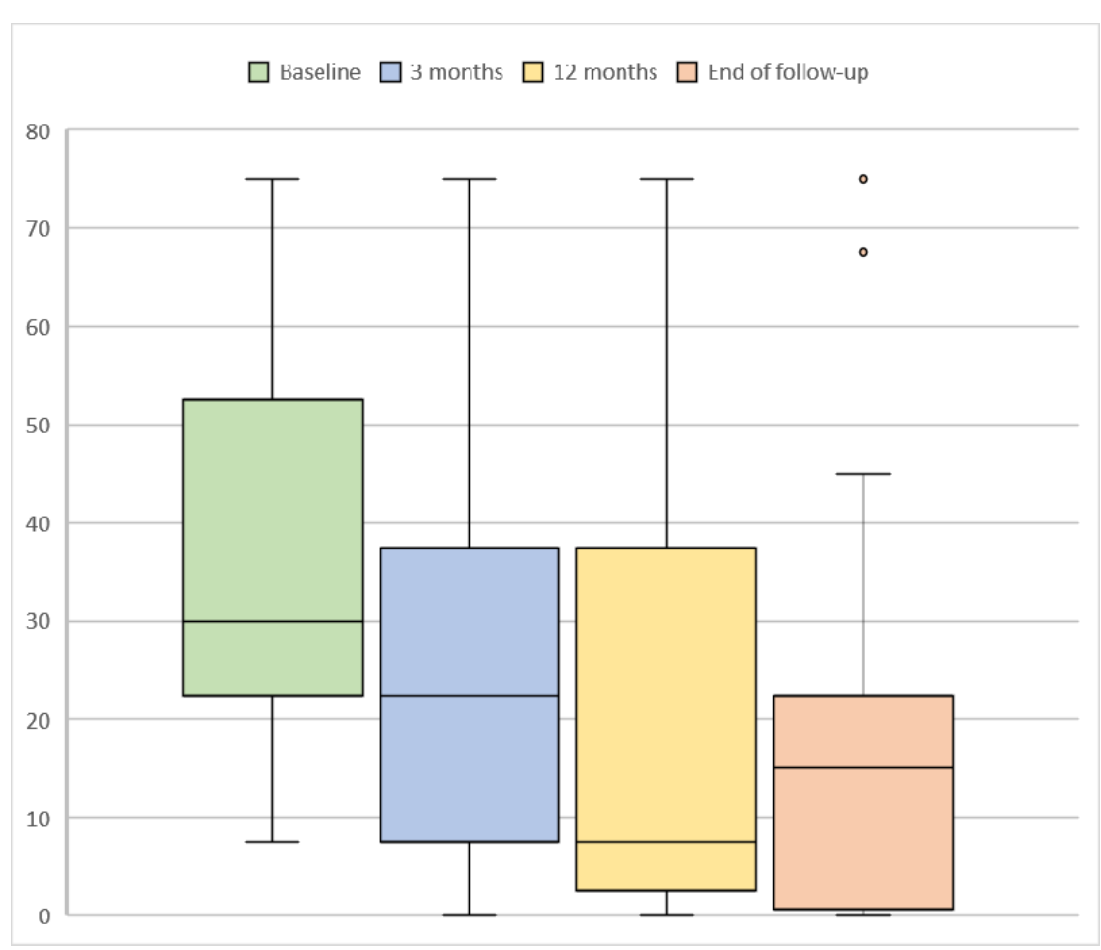
Figure 2. Evolution of weekly number of cluster headache attacks at baseline and after occipital nerve stimulation. Median and ranges are shown. n = 17 (no missing values between the groups). p values: 0.012 (baseline—3 months), 0.006 (baseline—12 months), 0.041 (baseline—end of follow-up).